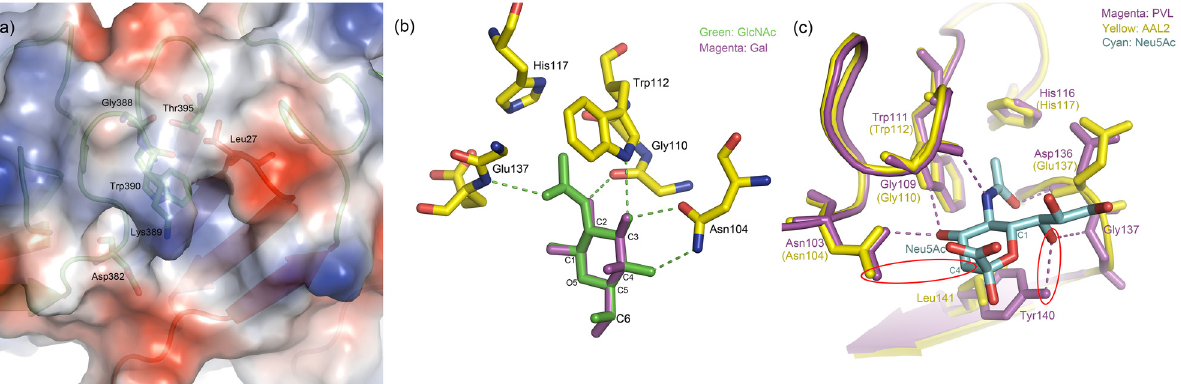
Fig 6. (a) Surface electrostatic potential diagram of WI that shows Lys395 blocked the potential glycan binding pocket. (b) Comparison between GlcNAc and Gal in conformation in the binding pocket of WIII from AAL2. (c) Superposition of the binding pockets in WIII from AAL2 (yellow) and PVL (magenta) shows that Neu5Ac (cyan) is not a specific ligand for AAL2.